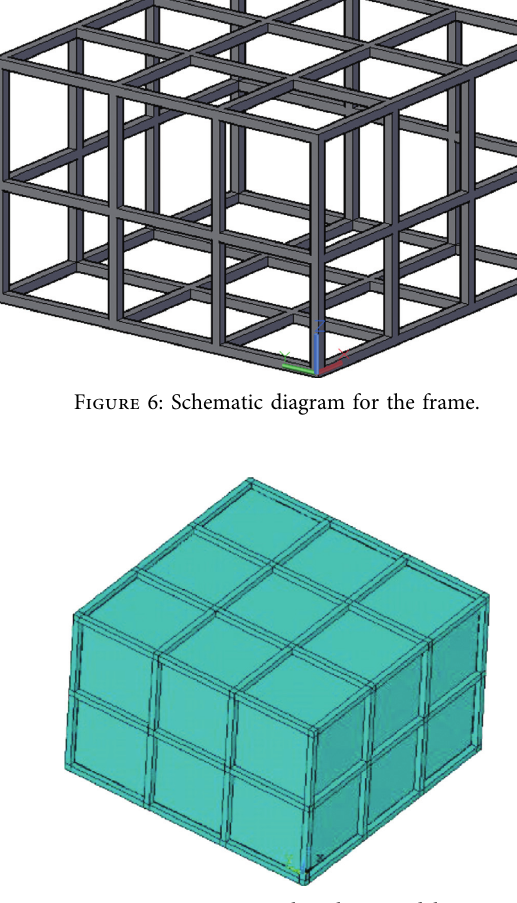
Figure 7: Structural analysis model.